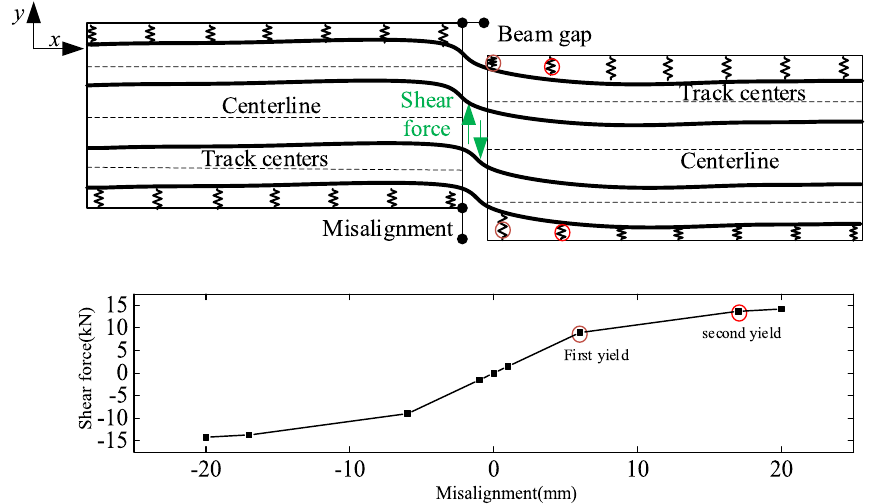
Fig. 10 Fore-displacement behavior of the track constraint at girder ends